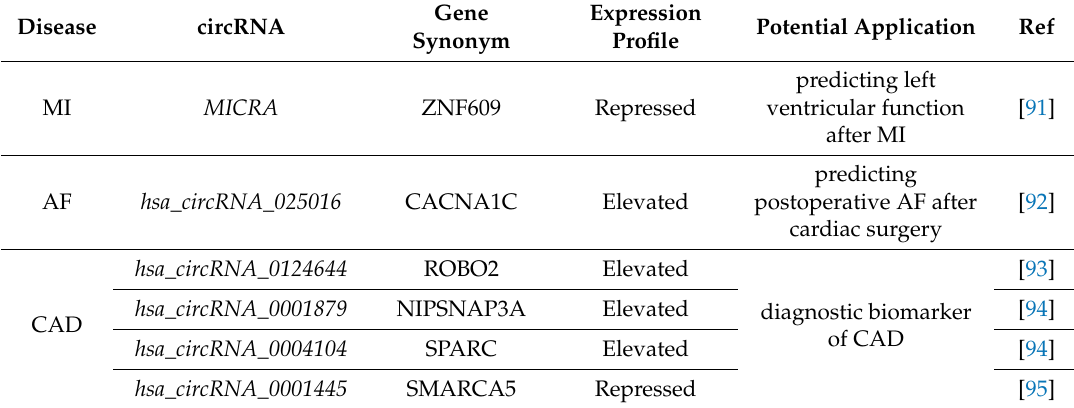
Table 1. List of potential circRNA biomarkers in heart disease. MI, myocardial infarction. AF, atrial fibrillation. CAD, coronary artery